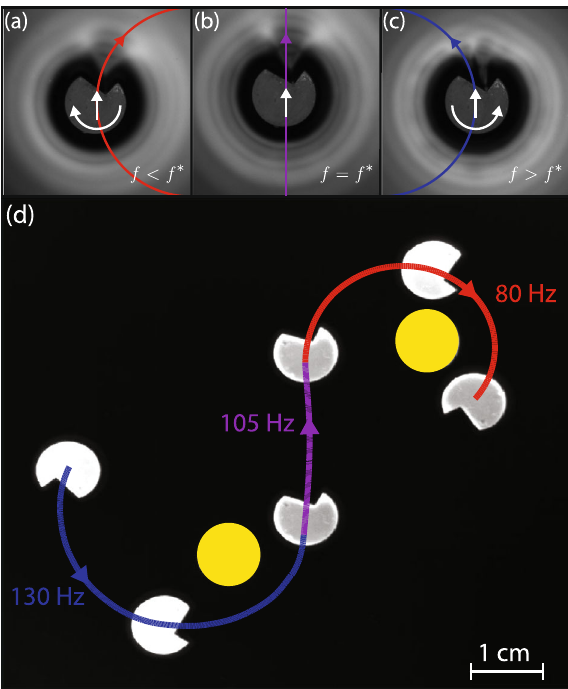
Fig. 5 Remote steering of a “ Pac-Man ” -shaped chiral active particle (CAP) via modulation of the driving frequency. The CAP translates in the direction of the wedge opening, but simultaneously rotates with a frequency-dependent direction. a For f < f * , the CAP tracks a clockwise arc. b When f = f * the CAP follows a straight line. c For f > f * , the CAP executes a counter-clockwise arc. d The driving frequency can be tuned in real-time to force the CAP along a bespoke trajectory. Here, three frequencies are used to successfully navigate the CAP between (yellow) circular markers placed on the bottom of the fl uid bath. See Supplementary Movie 5 for a movie of the